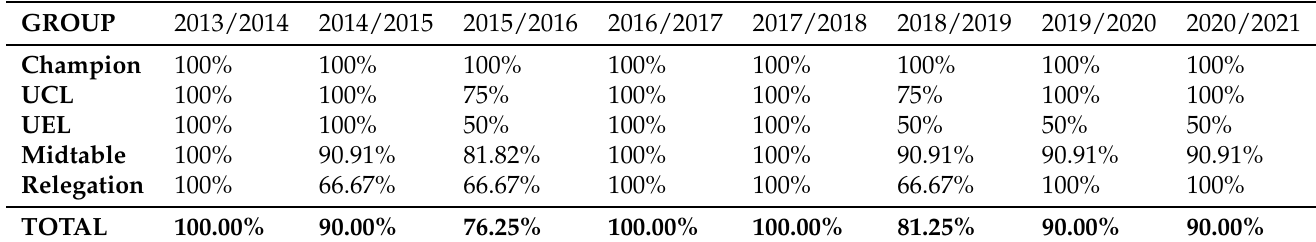
Table 4. Comparison of hits of Algorithm 1 with respect to the actual results of seasons